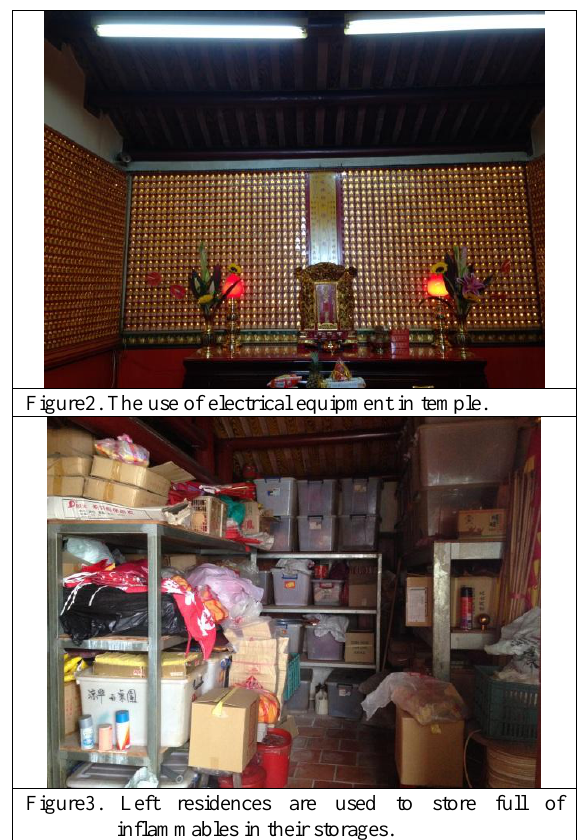
Figure3. Left residences are used to store full of inflammables in their storages.